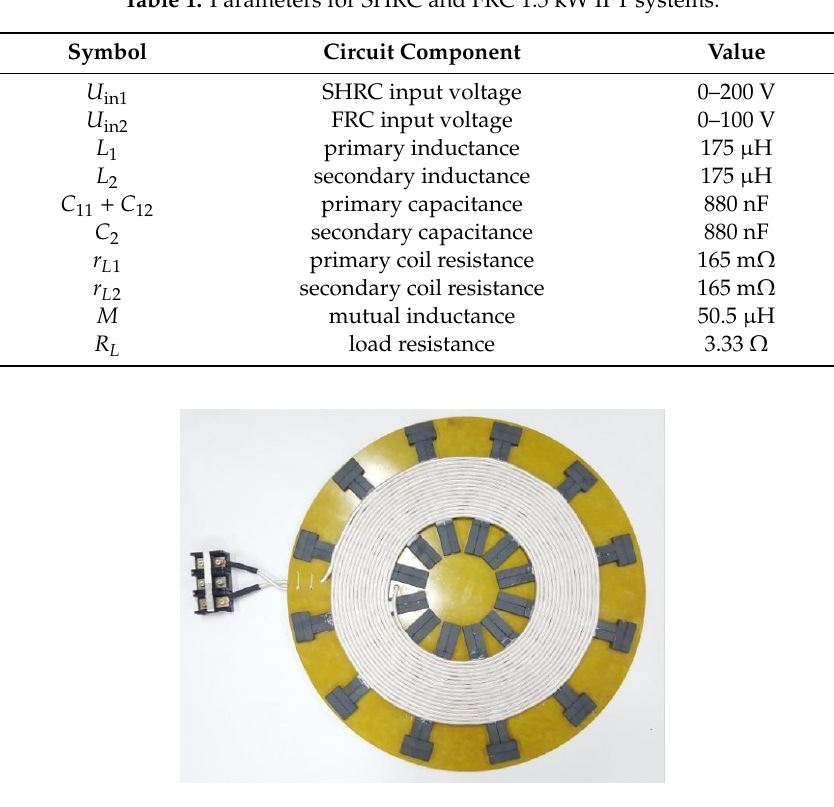
Figure 9. Structure of transmitter coil. Table 1. Parameters for SHRC and FRC 1.5 kW IPT systems.